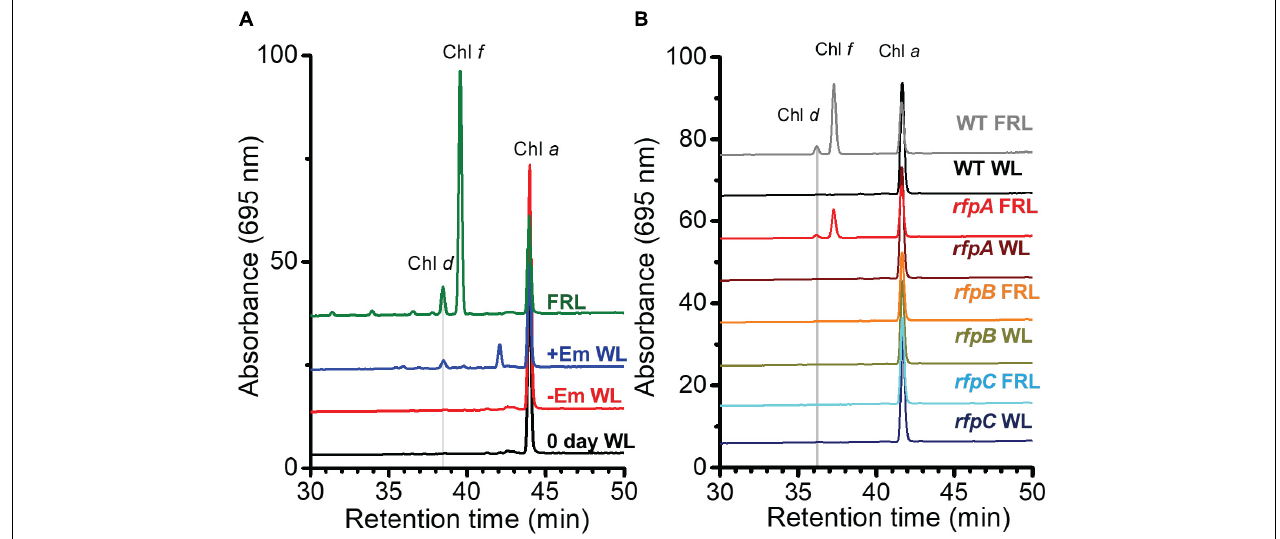
FIGURE 5 | RP-HPLC elution profiles showing that erythromycin (Em) induces Chl d formation in C. fritschii 9212. Pigments were extracted and separated by RP-HPLC with wavelength monitoring at 695 nm as shown. Pigments extracted from WT cells acclimated to FRL were used as standards for Chl a , Chl d , and Chl f as indicated on the figure panels. Each trace represents a specific culture condition or strain. (A) Pigments were extracted from C. fritschii 9212 WT cells grown under four conditions: WL at time 0 (0 day WL; black line); cells grown in WL without Em (–Em WL; red line) for 4 days; cells grown in WL with 5 µ g Em ml − 1 for 4 days (+Em WL; blue line); and cells fully acclimated to FRL for more than 1 month (FRL; green line). (B) Pigments were extracted from WT and rfpA , rfpB , and rfpC mutant cells of C. fritschii 9212 that were grown in WL and transferred to FRL for 6 days. All cells were grown without addition of Em to the medium. The genotype of each mutant was verified by PCR analyses (see Supplementary Figure S4 ). For additional details, see